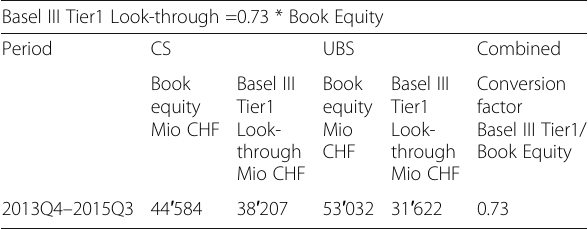
Table 11 Conversion factor: Basel III Tier1 Look-through to Book